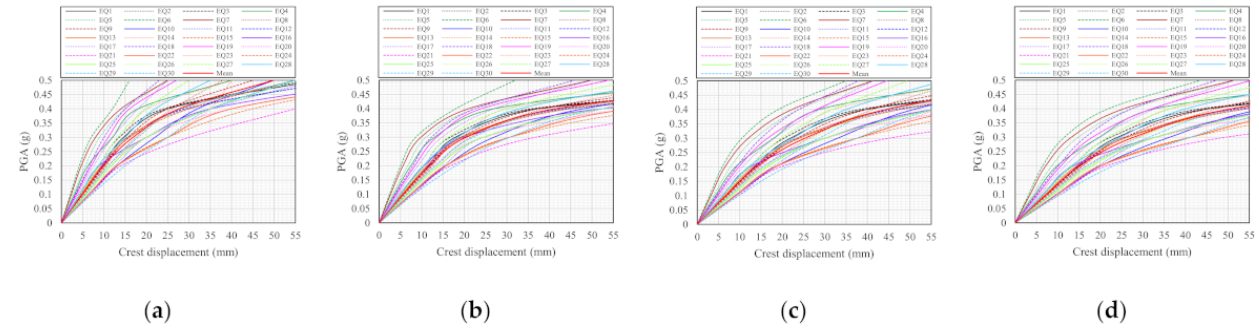
Figure 14. Incremental dynamic analysis (IDA); ( a ) 0 years, ( b ) 25 years, ( c ) 50 years, ( d ) 75 years.